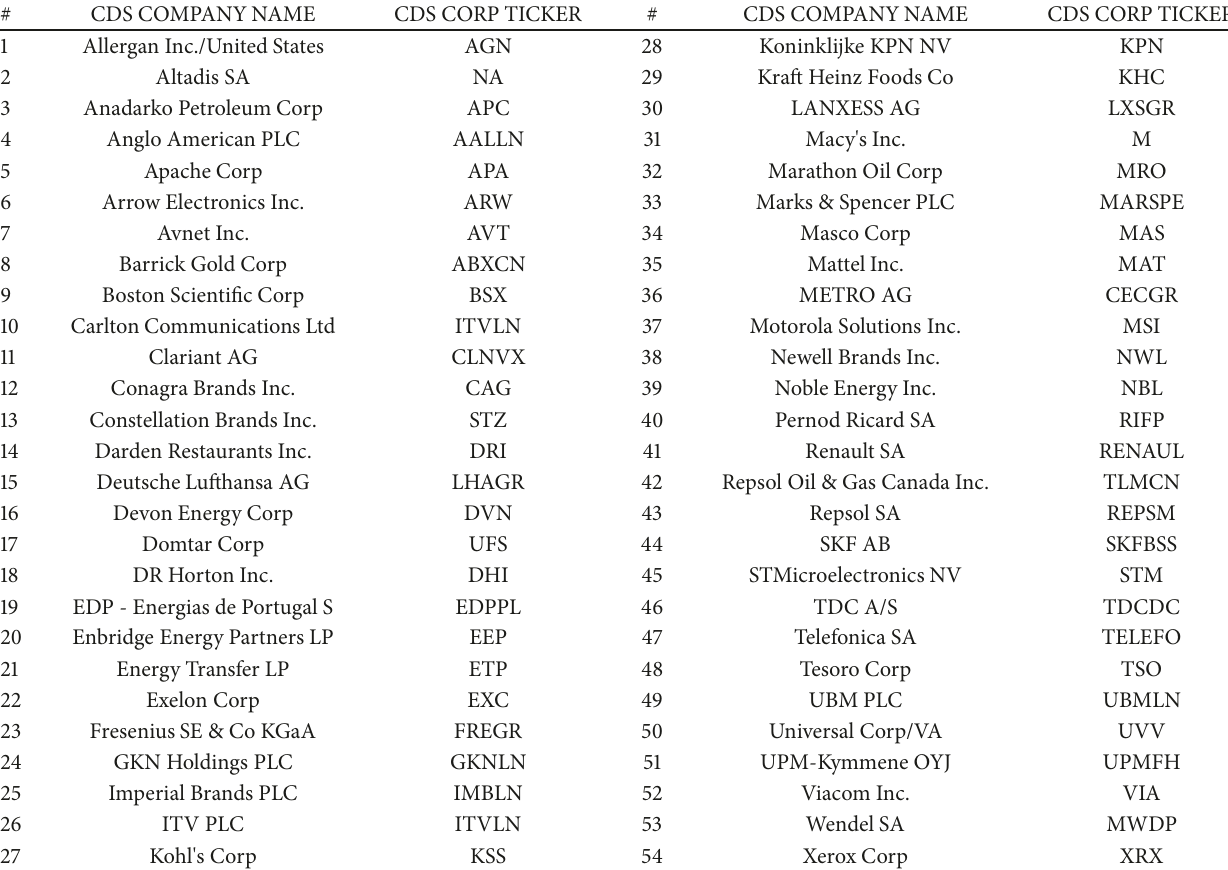
Table 7: Companies used for the IG BBB- sample.